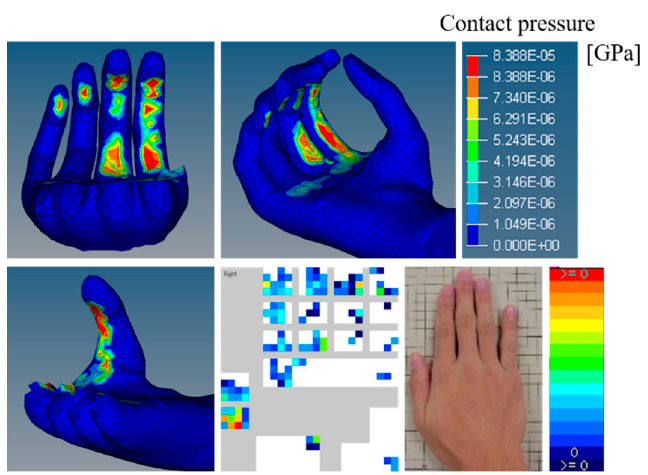
Figure 9. Comparison of the contact pressure distribution between the FE simulation result and experimental result. Red color denotes high contact pressure while blue–black color denotes low contact pressure.